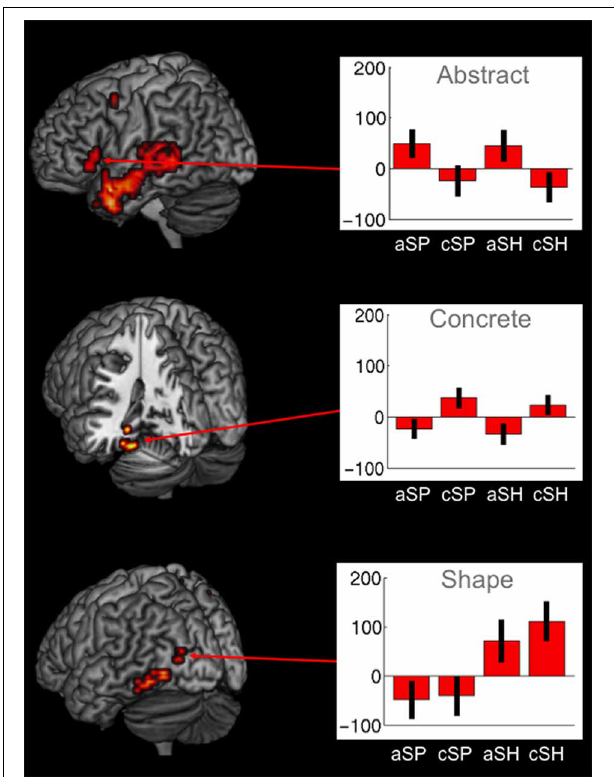
FIGURE 3 | Significant brain activations for abstractness, concreteness as well as for shape-related co-verbal gesture processing (whole-brain,